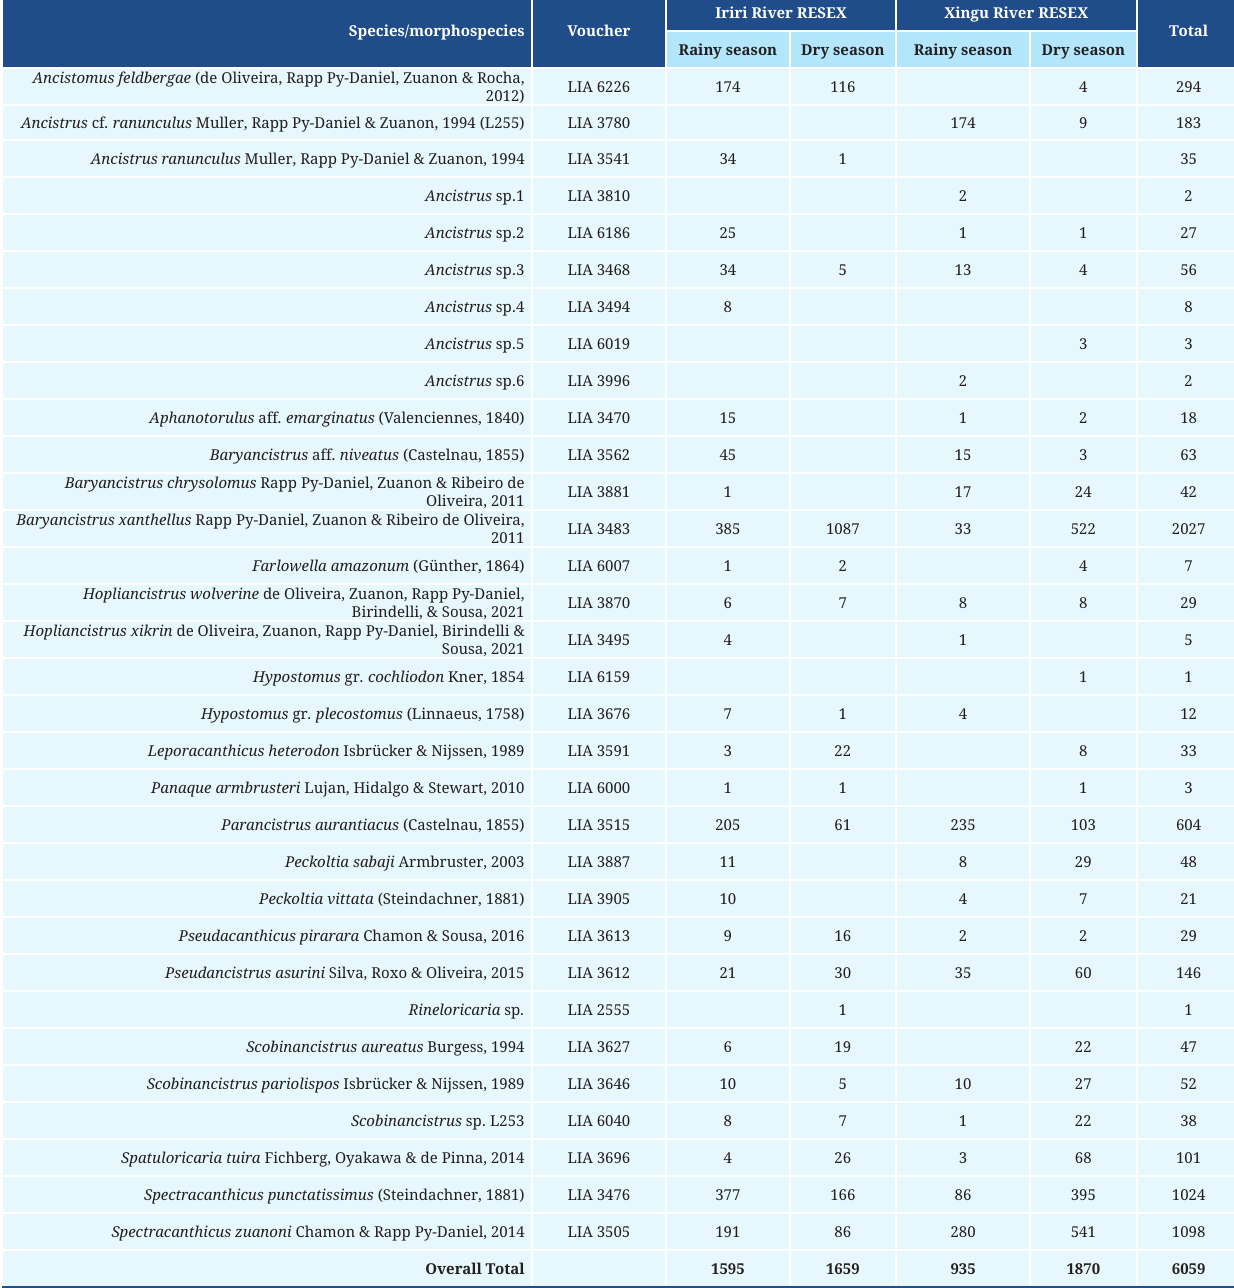
TABLE 1 | List of registered species and number of collected specimens in the Xingu and Iriri River RESEXes. Iriri River Species/morphospecies Voucher